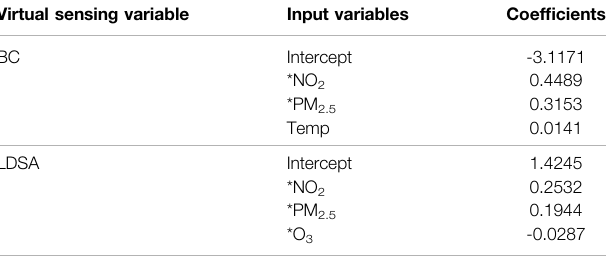
TABLE 3 | Results showing the coef fi cients of the developed black carbon (BC, μ g m − 3 ) and lung deposited surface area (LDSA, μ m 2 cm − 3 ) proxy using the referencemeasurementsatMäkelänkatustreetcanyonsite.Asterisk(*)represents a natural logarithm of the input variable. Virtual sensing